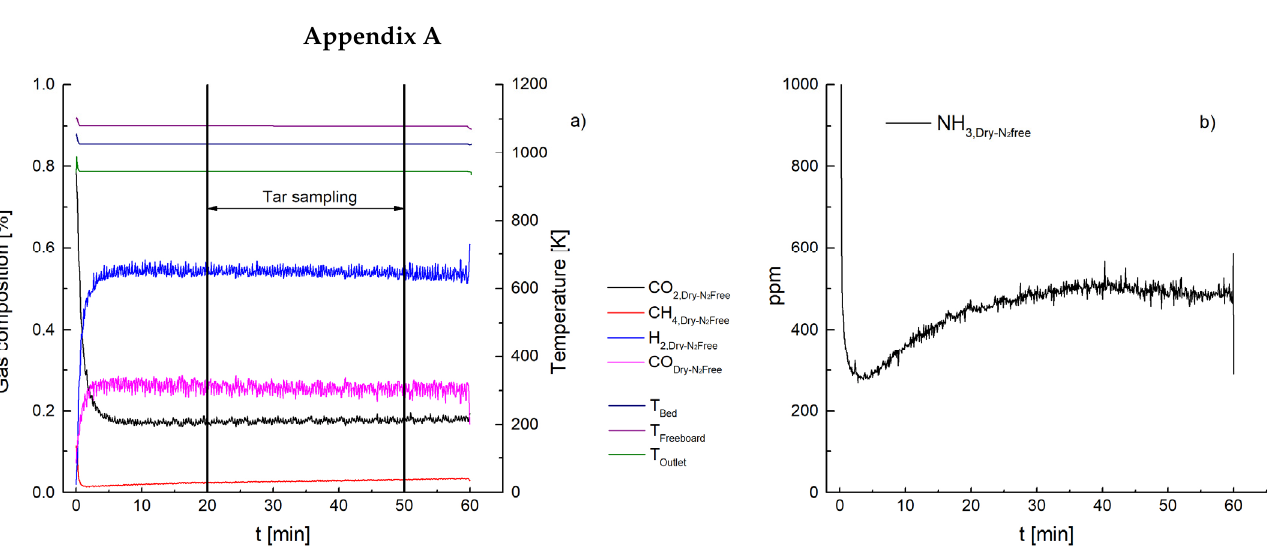
Figure A3. Temperature and gas composition ( a ) and ammonia content ( b ) during test 3.